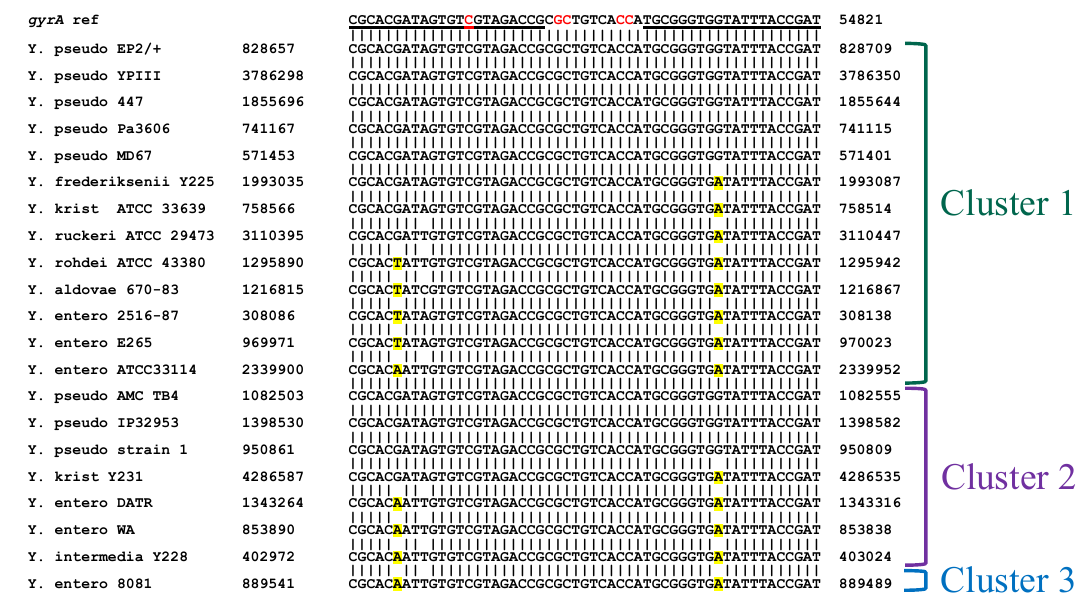
Figure 7. Alignment of interrogated gyrA sequences with published reference sequences from all non- pestis Yersinia spp. strains tested (see Table 11). The Y. pestis reference sequence is shown at the top with primer sequences underlined. Mutations at the positions shown in red have been demonstrated to cause quinolone resistance [37,38]. Sequence substitutions predicted to cause a decrease in T m are highlighted in yellow. Y. entero = Y. enterocolitica ; Y. krist = Y. kristensenii ; Y. pseudo = Y. pseudotuberculosis.